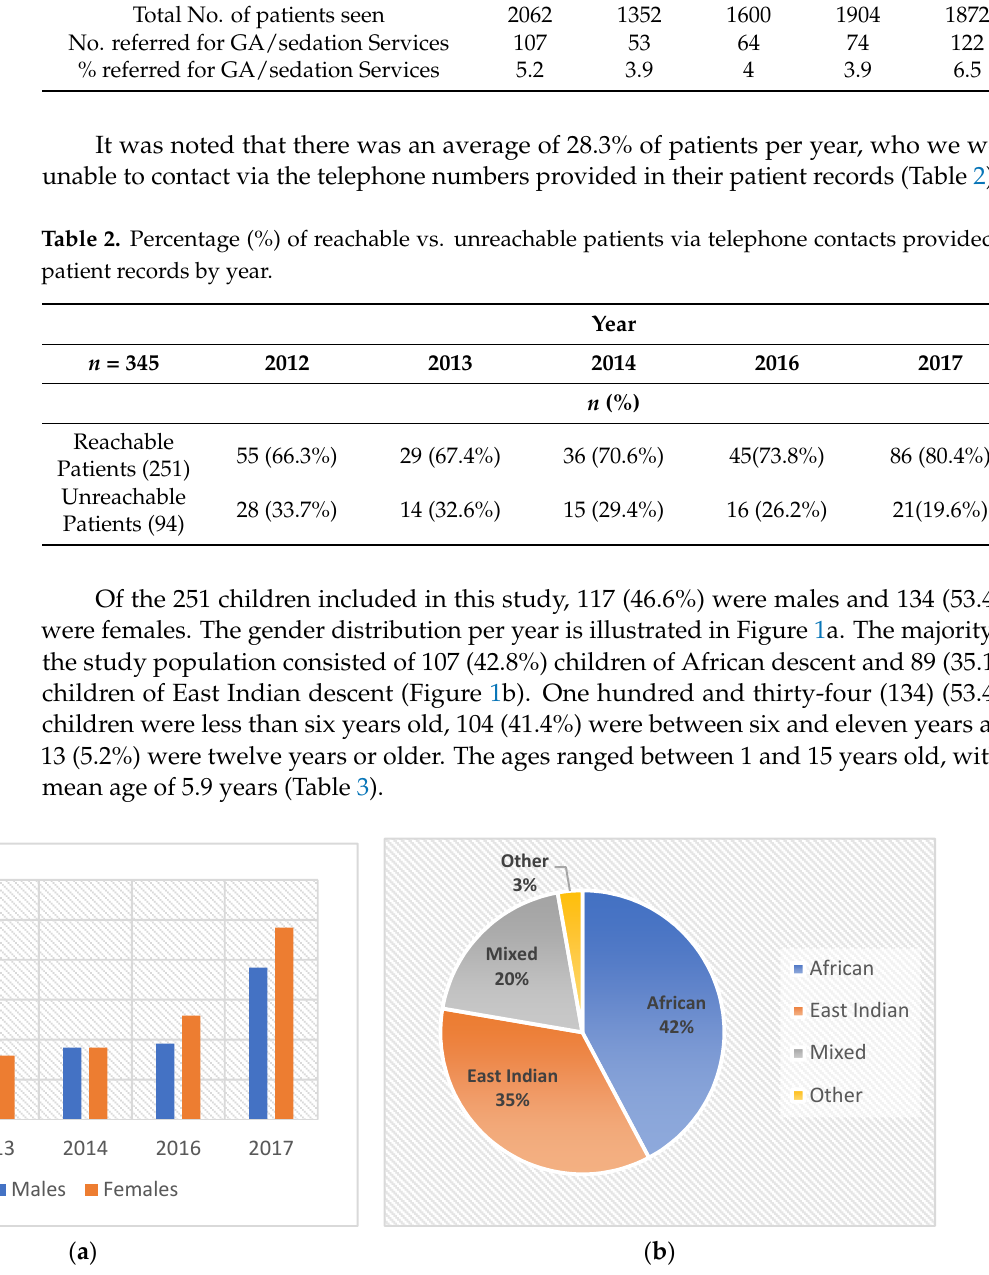
Figure 1. ( a ) Graph showing the average gender distribution of referred patients over the 5-year period. ( b ) Chart representing the overall ethnicity of the referred GA/sedation patient population (%). Table 3. Age of referred patients by year.